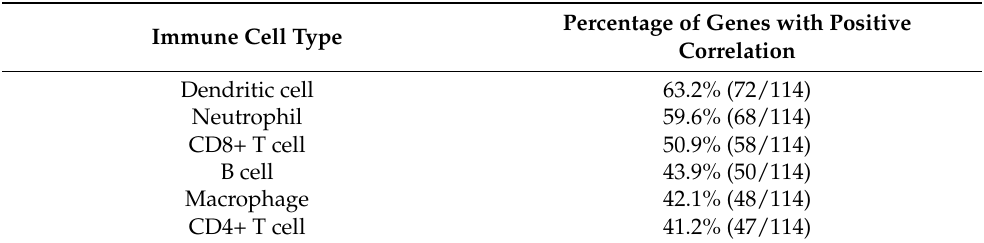
Table 3. Percentage of BC female-biased genes with positive correlation for six immune cell types based on results from TIMER2.0.